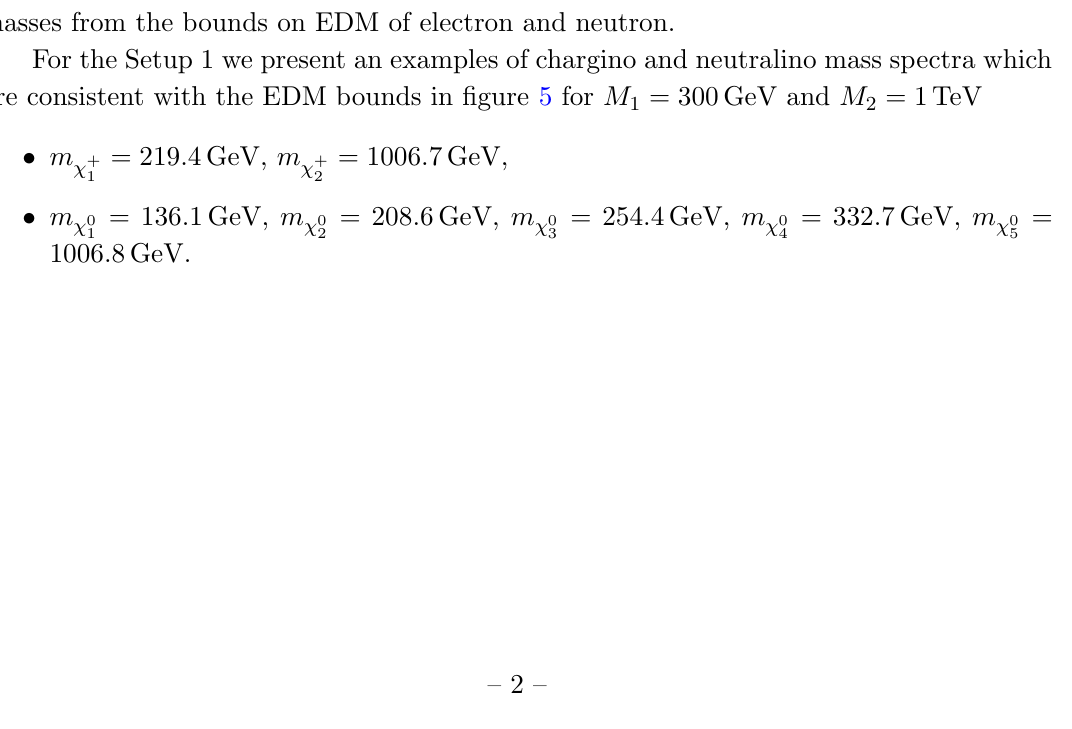
=T . Bounce pro(cid:12)les are presented in (cid:12)gure 5. 3 c for the 2